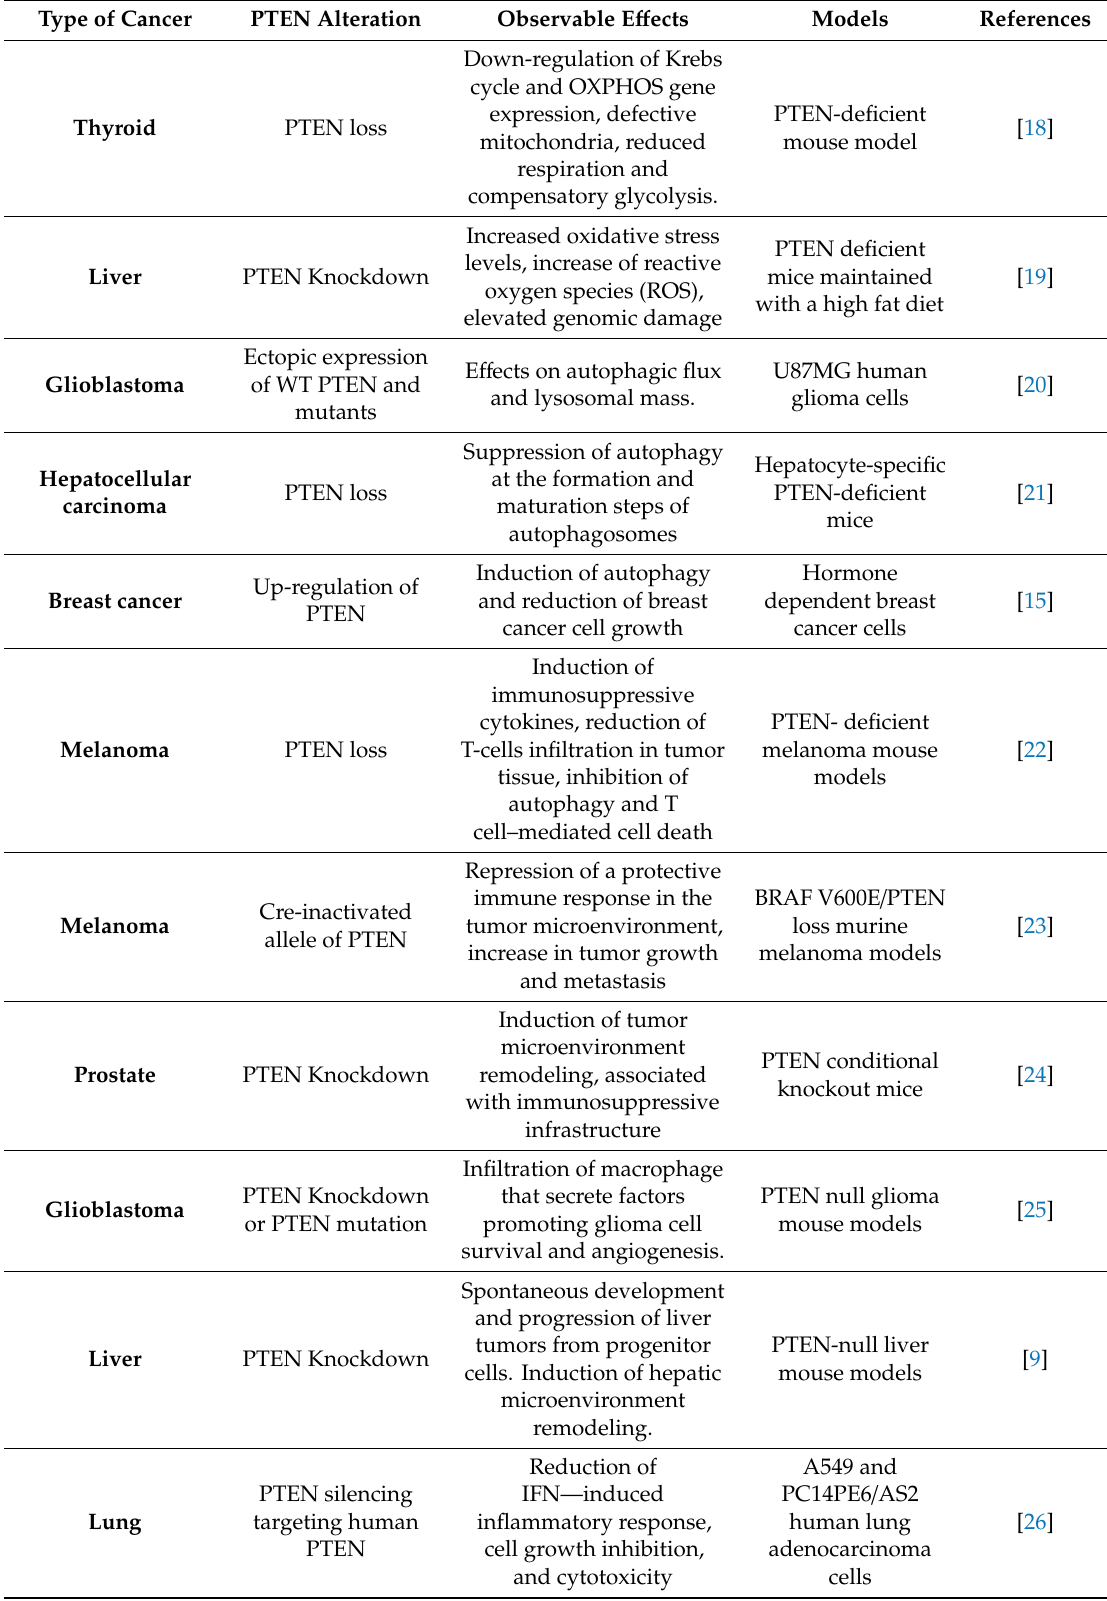
Table 1. List of PTEN alteration, observable e ff ects, and experimental